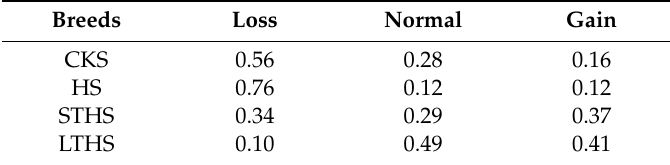
Table 2. Frequency of di ff erent CNV types in four sheep breeds.